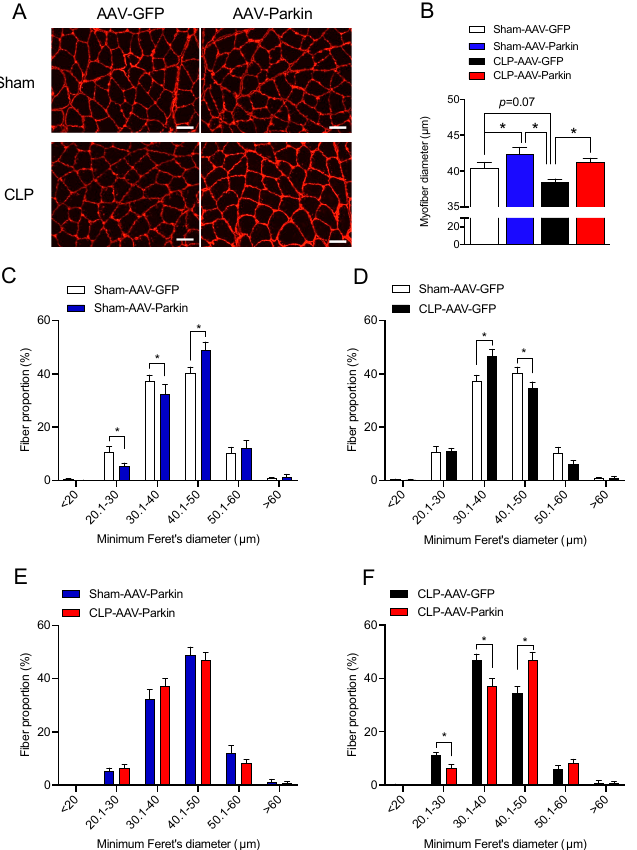
Figure 2. The impact of Parkin overexpression and sepsis on skeletal muscle fiber size. ( A ) Representative gastrocnemius (GAS) cryosections stained for laminin in all experimental groups. Scale bar: 50µm. ( B ) Quantification of minimum Ferret diameter of GAS myofibers of Sham and CLP animals injected with either AAV-GFP or AAV-Parkin. ( C ) Minimum Ferret distribution of the GAS myofibers of Sham AAV-GFP ( n = 8 mice; 316 ± 21 fibers per GAS were traced) vs. Sham AAV-Parkin ( n = 8 mice; 300 ± 5 fibers per GAS were traced). ( D ) Minimum Ferret distribution of the GAS myofibers of Sham AAV-GFP ( n = 8 mice; 316 ± 21 fibers per GAS were traced) vs. CLP AAV-GFP ( n = 6 mice; 345 ± fibers per GAS were traced). ( E ) Minimum Ferret distribution of the GAS myofibers of Sham AAV-Parkin ( n = 8 mice; 300 ± 5 fibers per GAS were traced) vs. CLP AAV-Parkin ( n = 6 mice; 304 ±